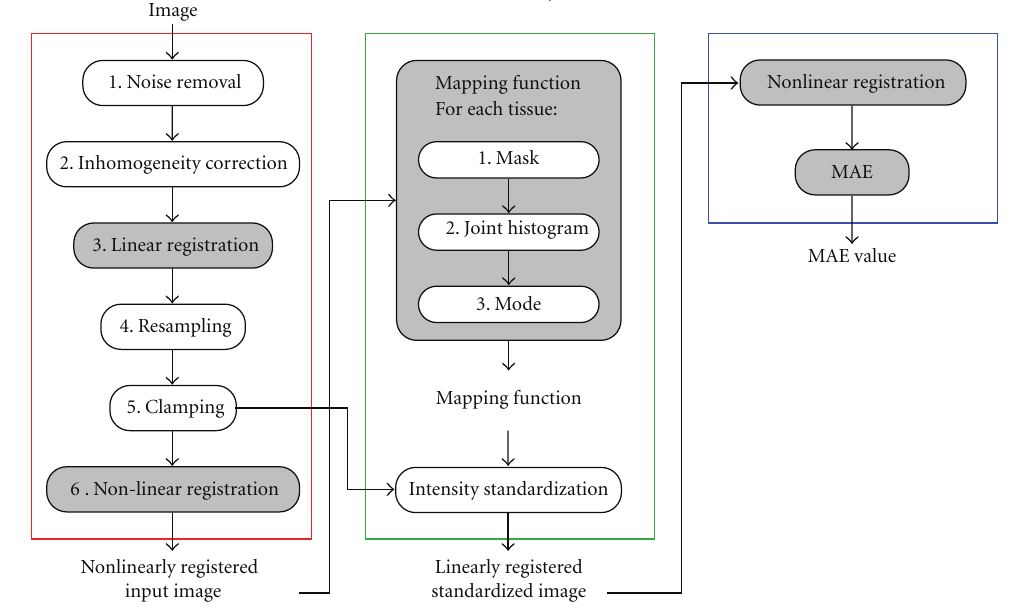
Figure 1: Flowchart showing the steps involved in image preprocessing (red), intensity standardization (green) and mean absolute error (MAE) computation for technique comparison (blue). The steps for which the standard image or its masks are required are shaded in grey. For the mapping function process, we summarize the three steps involved in